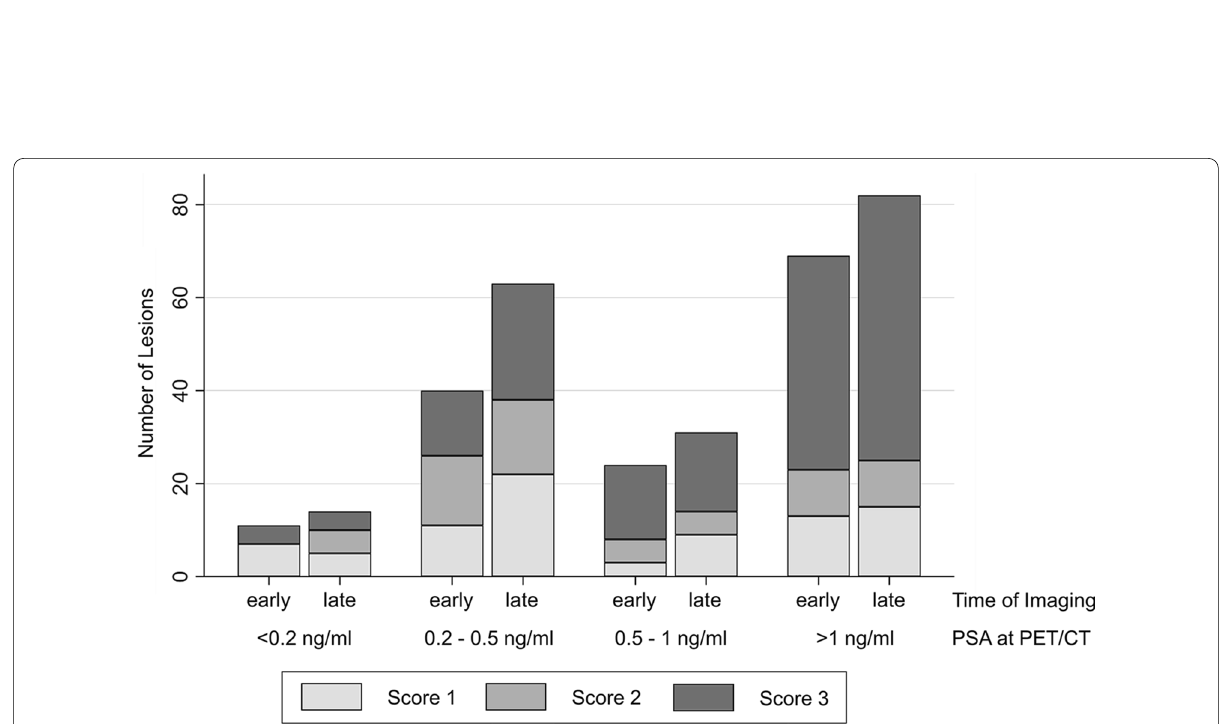
Fig. 3 PSMA expression score according to PROMISE criteria [25] and number of PCa-characteristic lesions identified on early and late imaging with the corresponding prostate-specific antigen (PSA) values at the time of